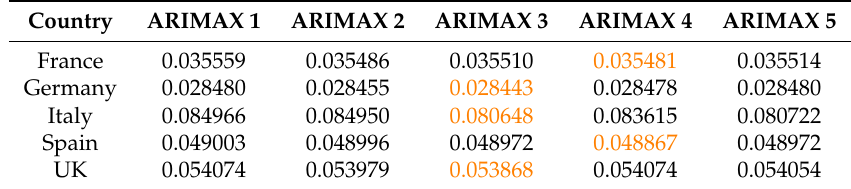
Table 13. RMSE for in-sample period of ARIMAX models for mean country volatility.